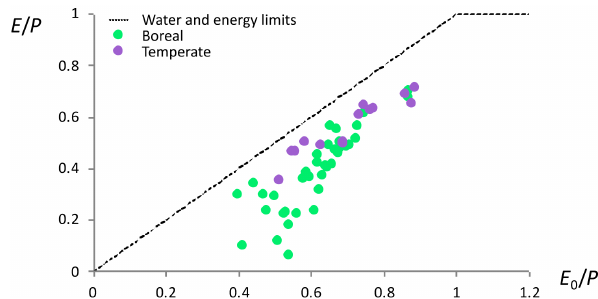
Figure 3. Hydroclimatic conditions in Budyko space. (a) Mean hy- droclimatic conditions of the 65 basins during the period 1961– 2012 illustrated in Budyko space, in terms of the aridity index ( E 0 /P ; x axis) and evaporative ratio ( E/P ; y axis) for temperate (purple) and boreal (green)